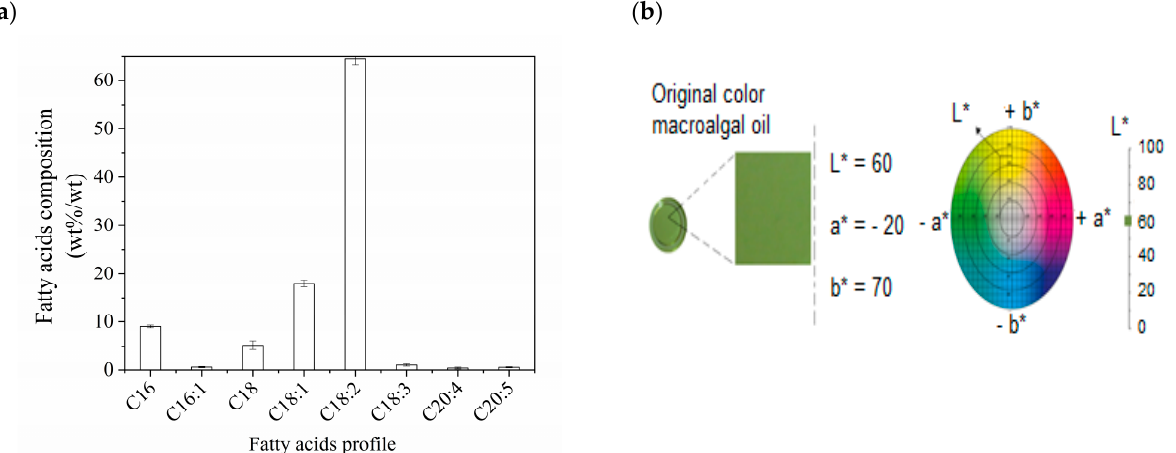
Figure 1. Macroalgae Fucus vesiculosus oil: ( a ) fatty acids profile determined by GC/FID analysis; ( b ) CieLab color analysis.